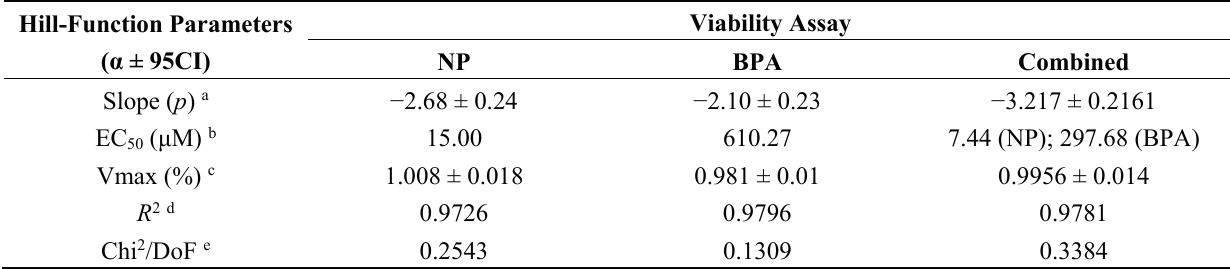
Table 1. The concentration-response curve of the viability assay satisfying the Hill function of the chemicals NP and BPA alone or in combination.